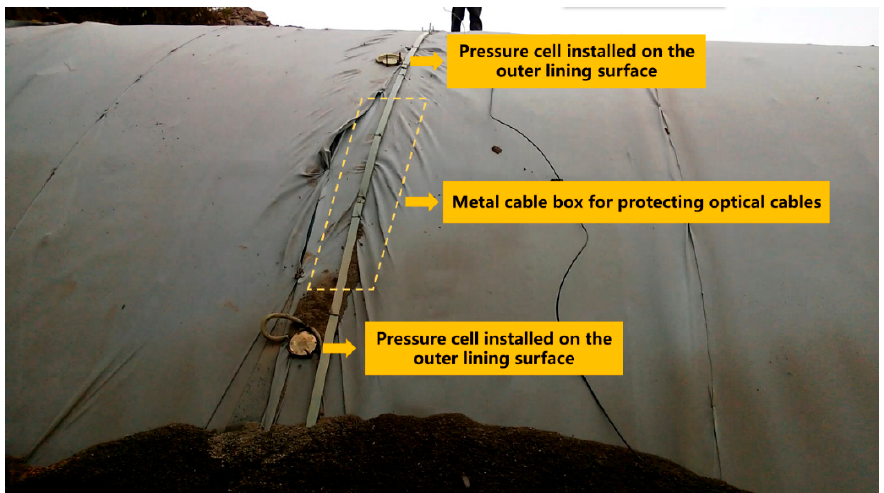
Figure 11. Pressure cells on the outer lining surface with metal cable boxes to protect the optical cables.